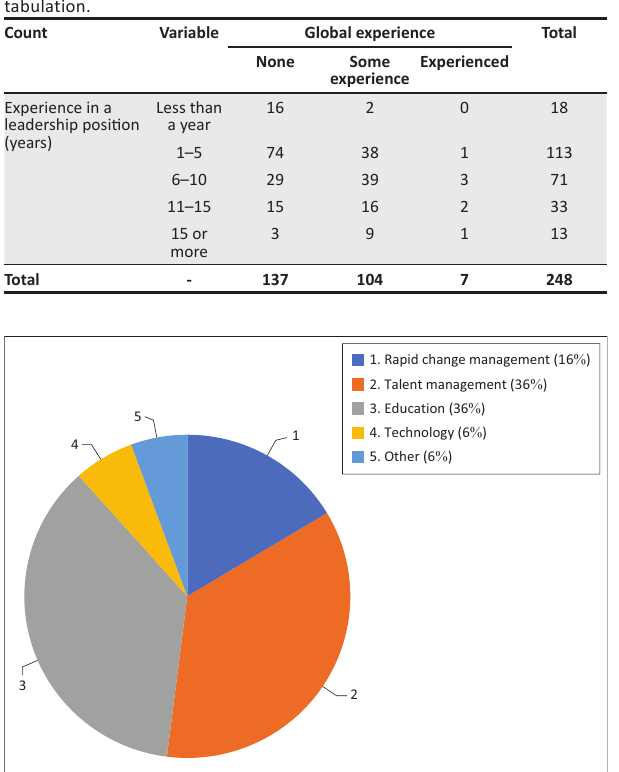
FIGURE 7: Proposed strategies for offsetting leadership